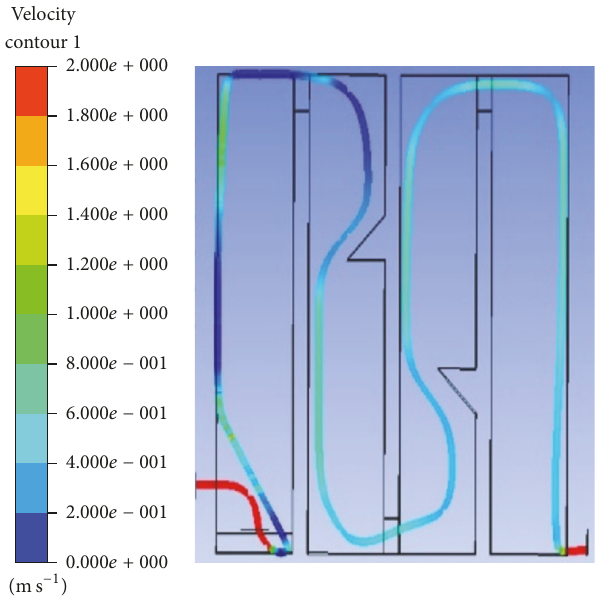
Figure 10: Streamline of fastest particles for final decay tank model.